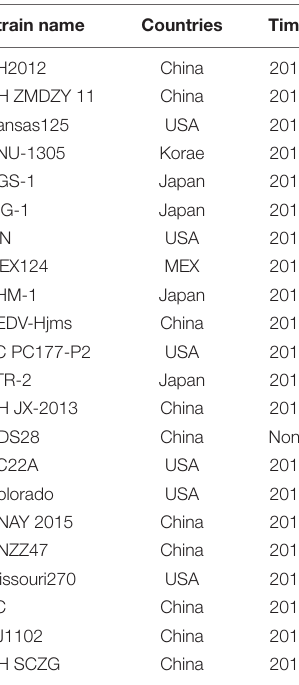
TABLE 1 | PEDV strains used in this